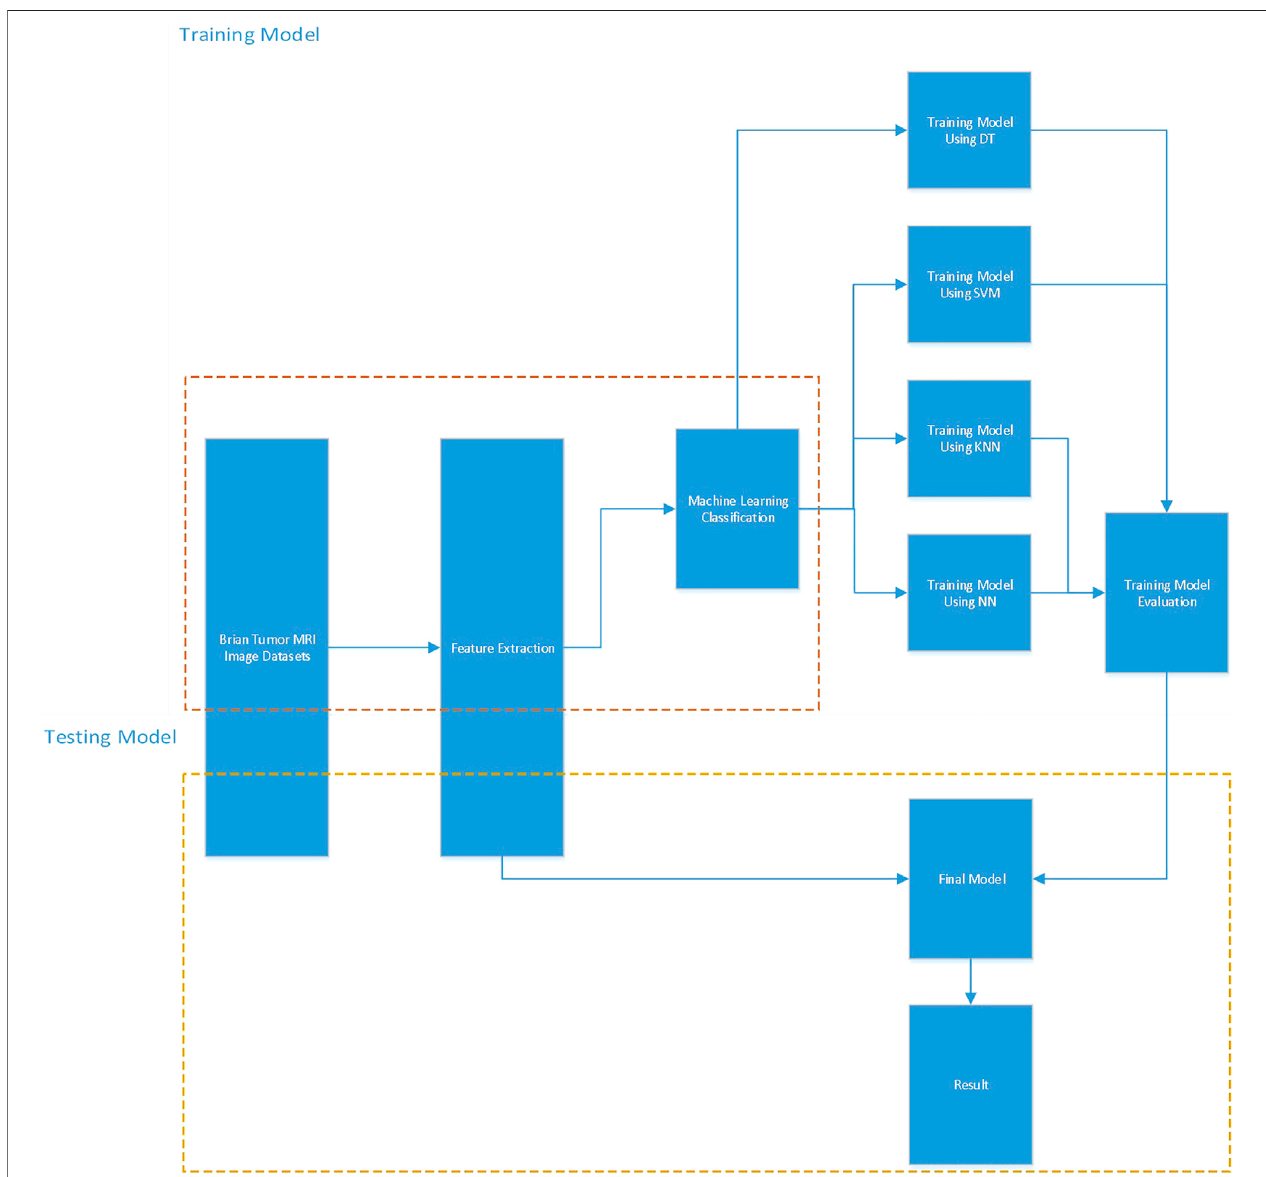
FIGURE 2 | Work fl ow diagram for training model and testing